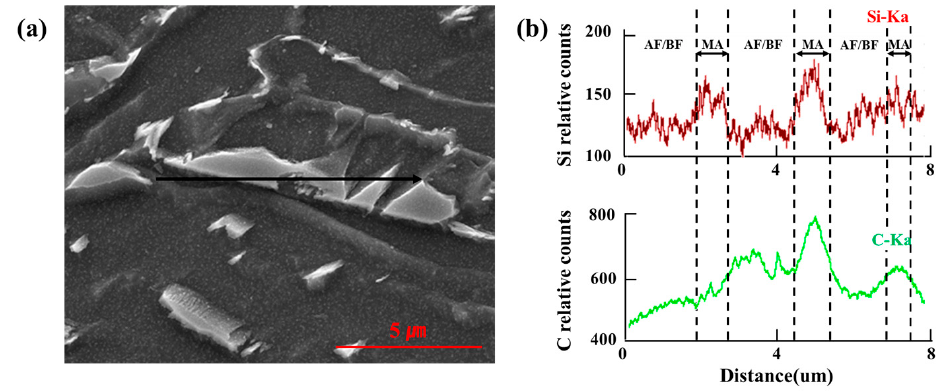
Figure 7. Microstructures and EPAM analysis of IRCGHAZ: ( a ) the shape of M–A constituent; and ( b ) line analysis of element segregated on the M–A constituent.